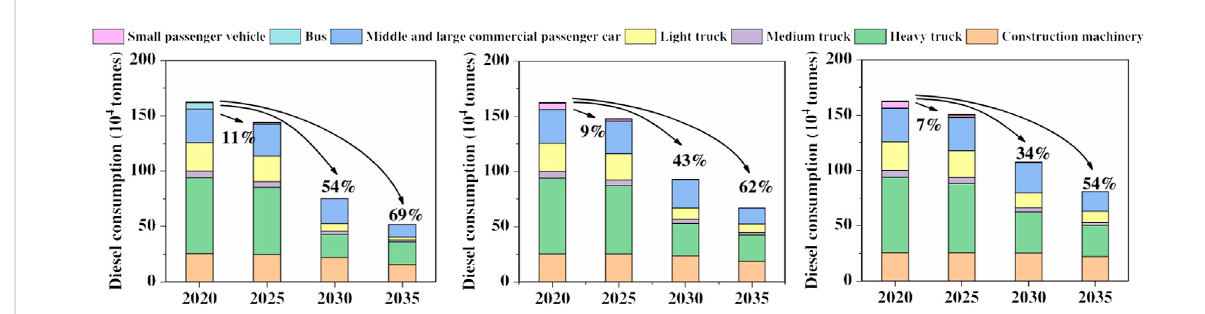
FIGURE 6 Fuel consumption of different types of vehicles in the low, medium, and high scenarios.